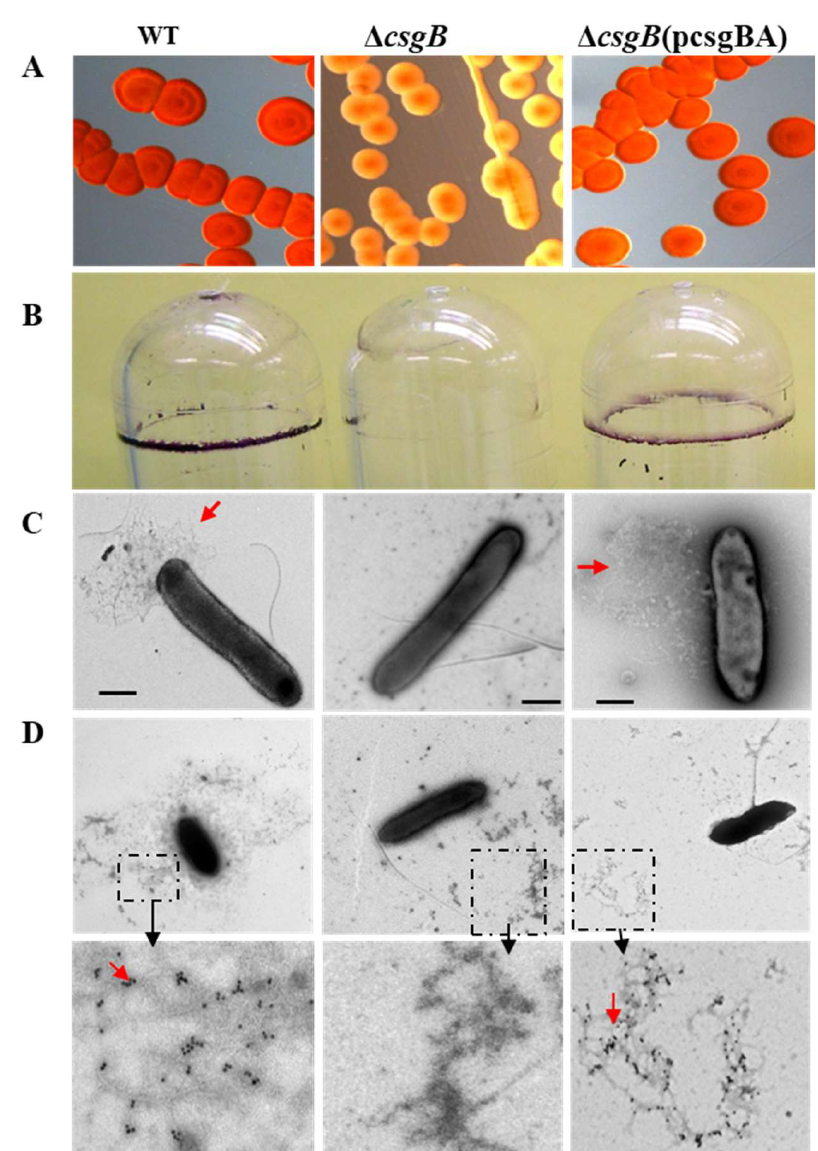
Figure 5. Δ csgB does not bind Congo red dye, does not form biofilm, and lacks curli fimbriae. ( A ) Bacterial overnight cultures of 43895 (WT), Δ csgB , and the complement Δ csgB (pcsgBA) were plated on Congo red indicator agar, incubated at 37 °C for 24 h, and examined visually. Colonies of Δ csgB were less red than the colonies of the WT and Δ csgB (pcsgBA) controls. ( B ) Bacterial cultures of the same strains were grown overnight, statically in LB at 37 °C. Medium was removed and pellicle-biofilms detected by staining with 1% crystal violet. The Δ csgB culture did not form a pellicle-biofilm as did the cultures of the WT and Δ csgB (pcsgBA) controls. Static overnight cultures of the same strains were individually applied on 300-mesh carbon-Formvar-coated copper grids and prior to EM examination (original magnification 10,000x) were ( C ) negatively stained with 1% phosphotungstic acid, pH 7.4 or ( D ) immunostained with rabbit anti-CsgA sera and goat anti-rabbit IgG conjugated with10-nm gold particles. Arrows point to anti-CsgA immunogold deposited onto curli fibers in the enlarged dash boxes. No curli fimbriae were detected with Δ csgB .